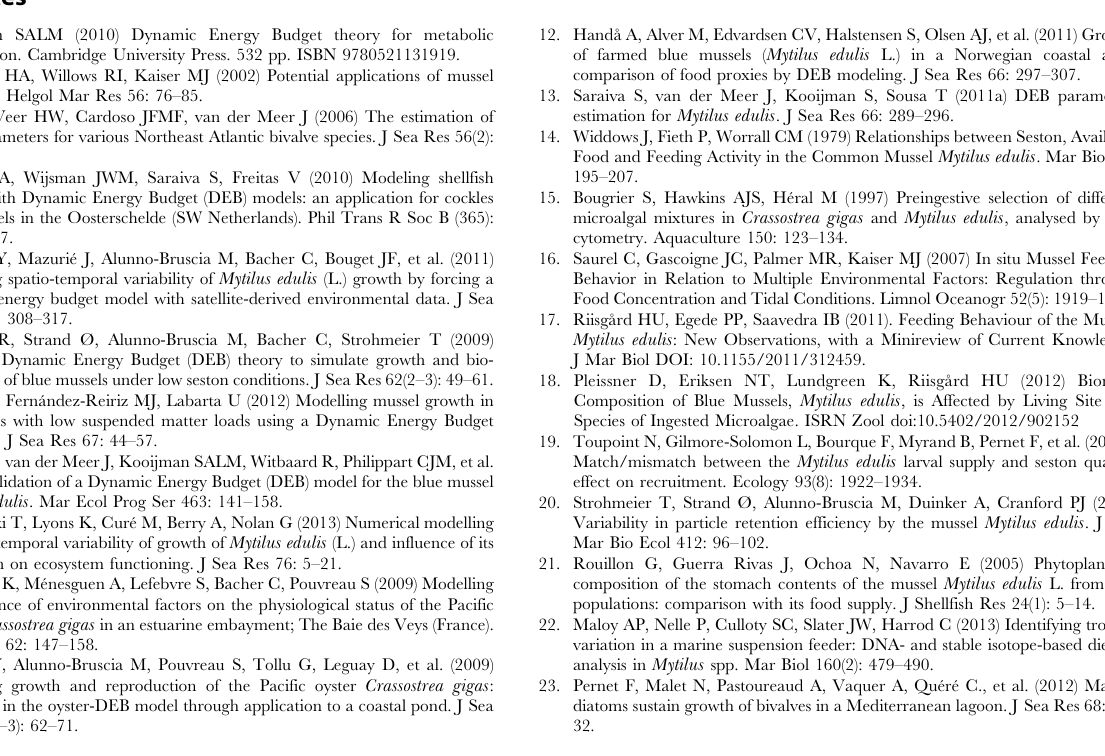
measured by the mean square model error (in black). Table S1 Plankton ecological characteristics. Family affiliation and social behavior are from [44]. Position in the water column is mostly from [45] and [28]. Habitats are from [48], [49], [50] and [51]. Biovolumes are from